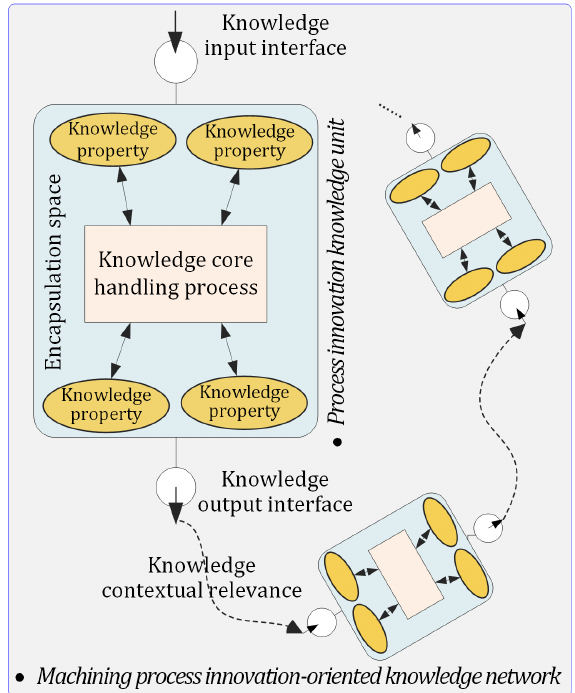
Figure 2. Illustration of the machining process innovation-oriented knowledge network.